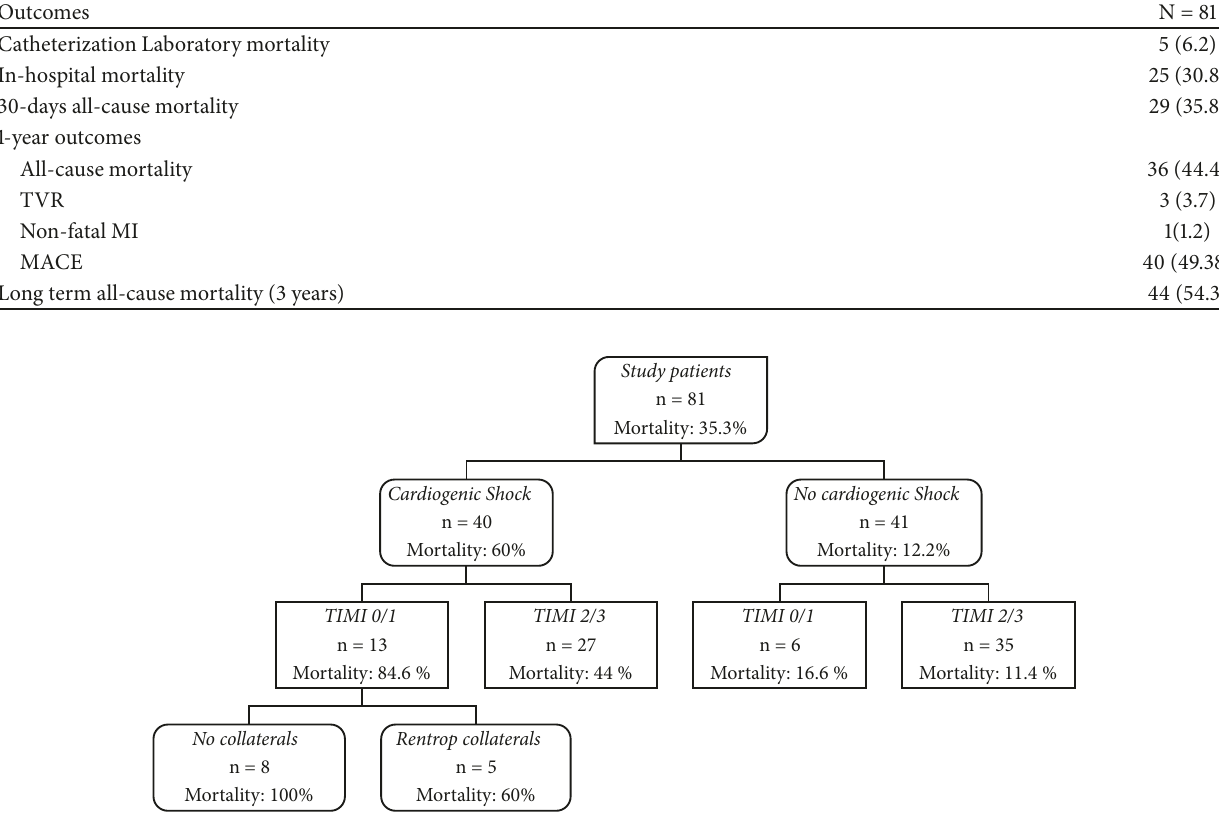
Figure 2: Thirty-day mortality in different patient subgroups—patients are grouped by cardiogenic shock, TIMI flow, and collaterals. TIMI = Thrombolysis in Myocardial